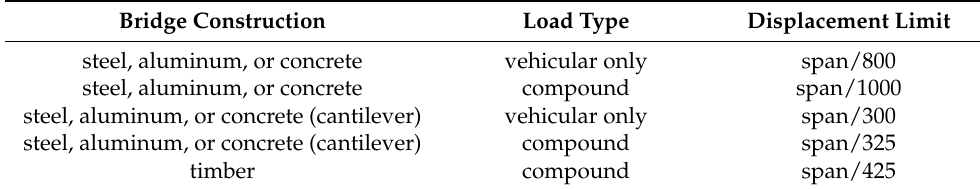
Table 1. Criteria for displacement limit on girder bridge. Compound load type (vehicular and pedestrian) has a stricter displacement limit criteria as pedestrian is more sensitive to movement due to the absence of a direct suspension